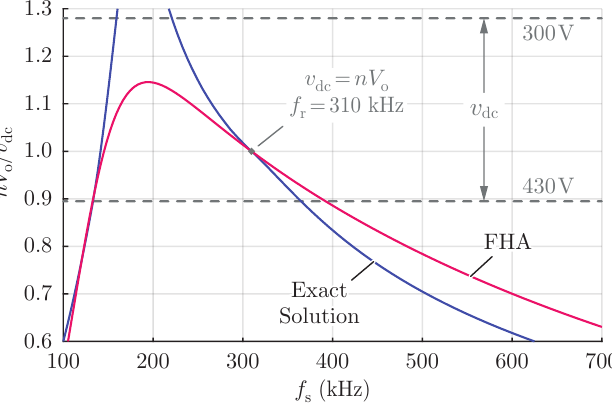
Figure 3. Graphical description of the output-to-input conversion ratio (normalized by the trans- former turns ratio n ) as a function of the switching frequency (control variable). The exact solution, obtained through circuit simulation, is compared to the fundamental-harmonic-approximation (FHA), where we see that the the FHA captures the correct monotonic behavior of the gain function. For the given v dc range (300V–430V) and the parameters selected in Section 2.1, the converter operates from 210kHz to